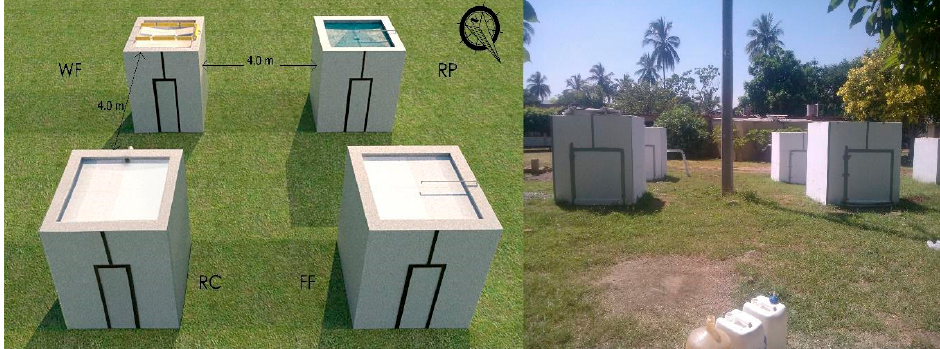
Figure 3. Left: distribution of the four experimental cells. Right: photo of the experimental area. Table 1. Constructive specifications of the experimental cells.